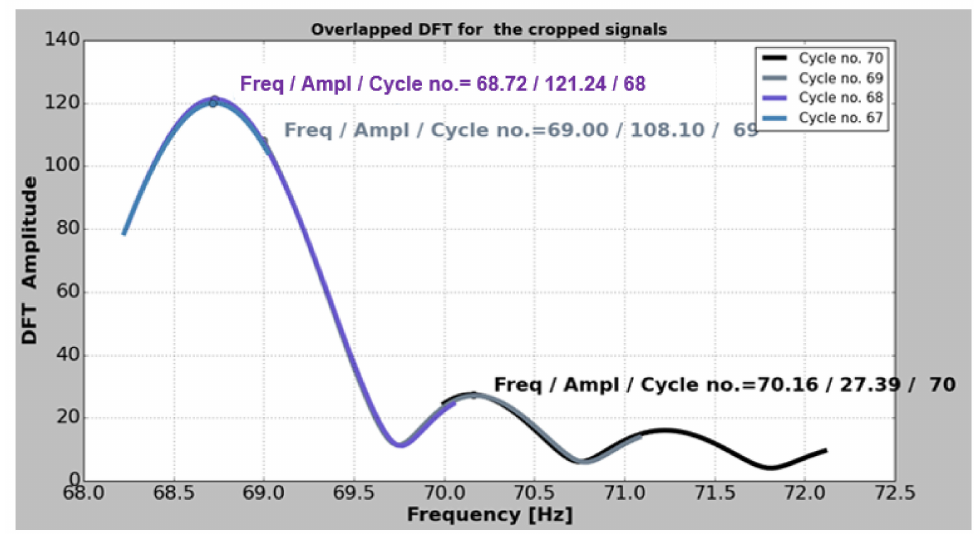
Figure 14. A window displaying the overlapped Discrete Fourier Transform (DFT).